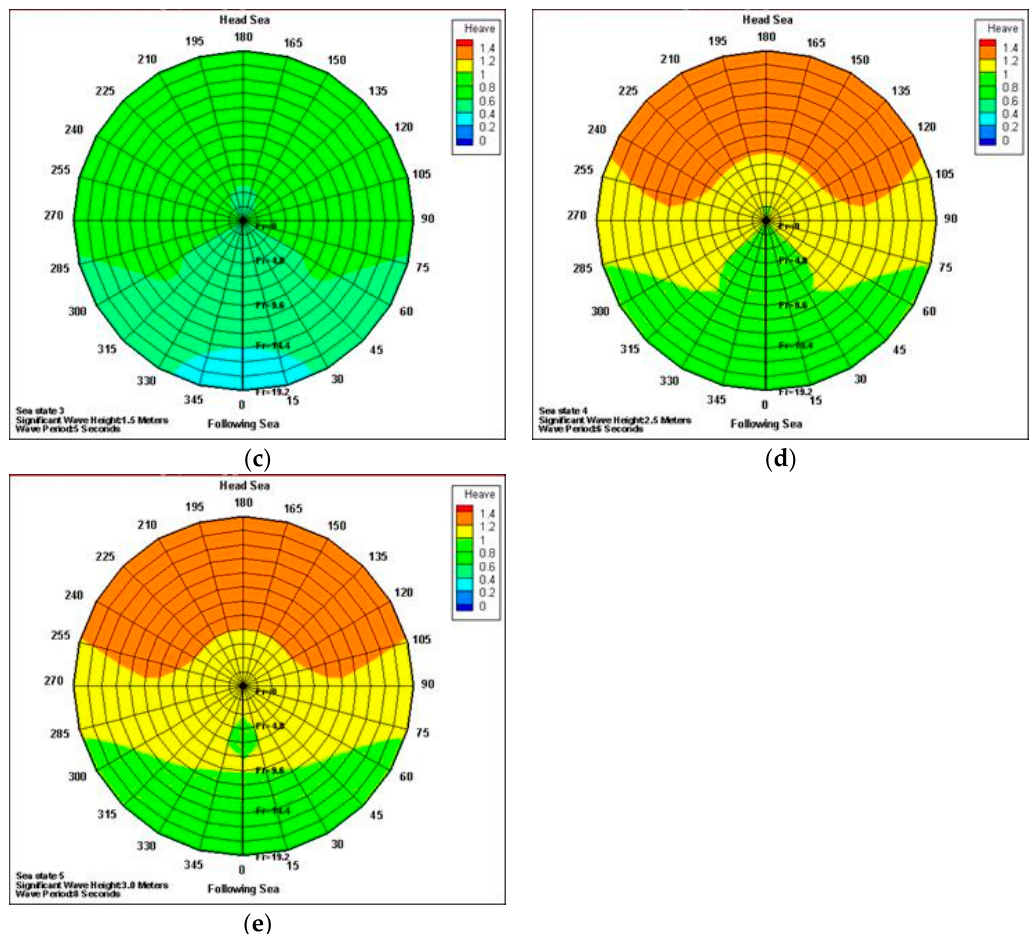
Figure 12. Speed polar diagrams of heaving motion in combination with sailing speeds and wave heading angles under sea states of ( a ) 1, ( b ) 2, ( c ) 3, ( d ) 4, and ( e ) 5, respectively.